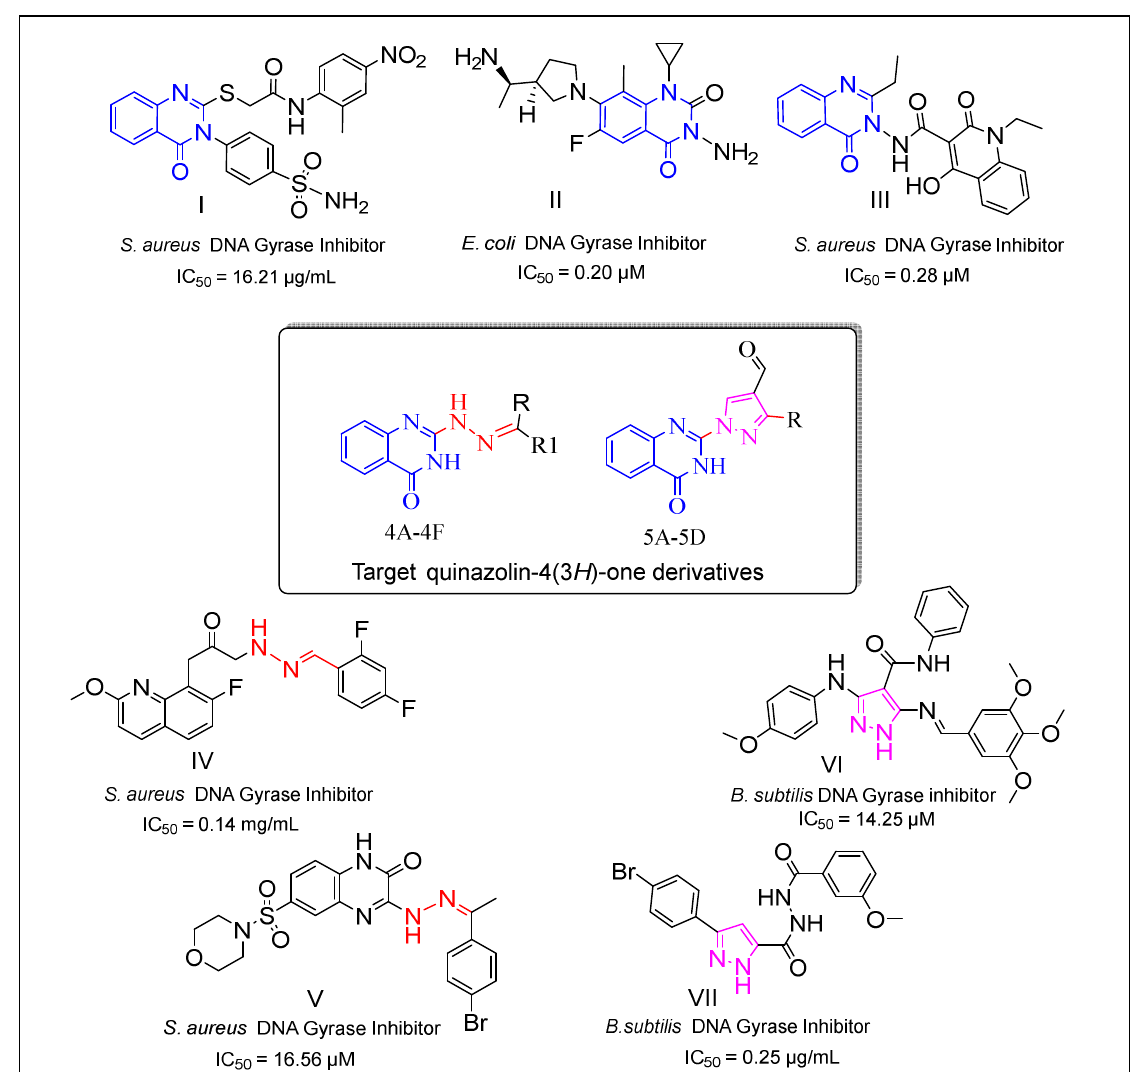
Figure 1. Reported quinazolin-4(3 H )one derivatives (I-III), hydrazone derivatives (IV,V), and pyra- zole compounds (VI,VII) as antimicrobial agents targeting DNA gyrase and the design of the target compounds.